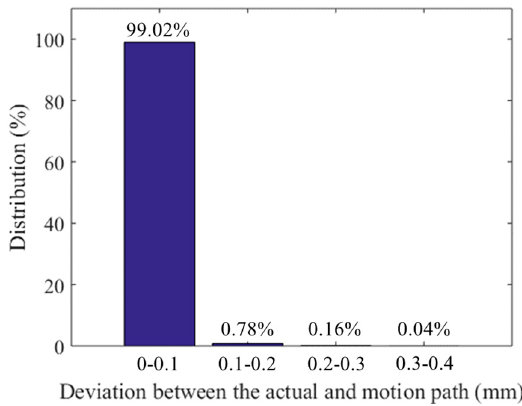
Figure 33. The distribution of path deviation between the actual path and the motion path of the workpiece during welding.